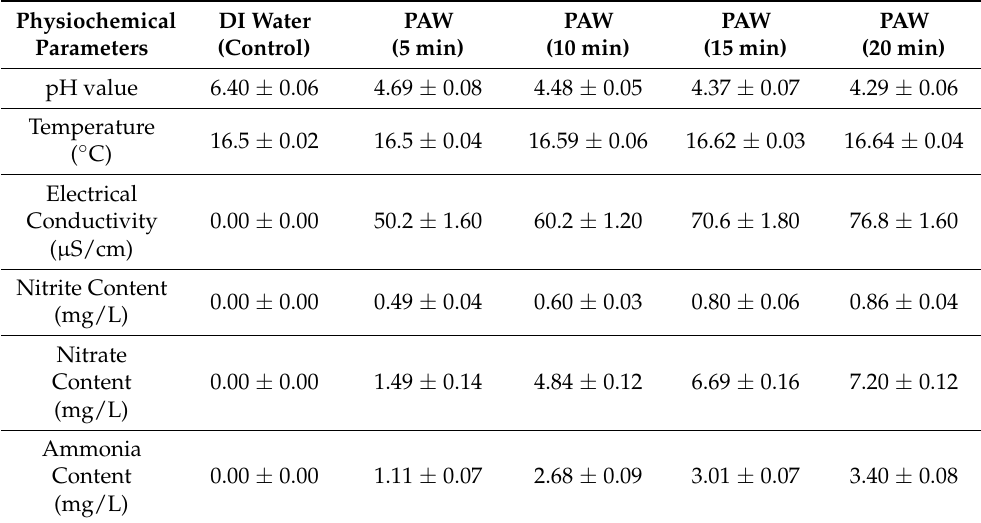
Table 1. Physiochemical Parameters of DI water prior to and after GAD